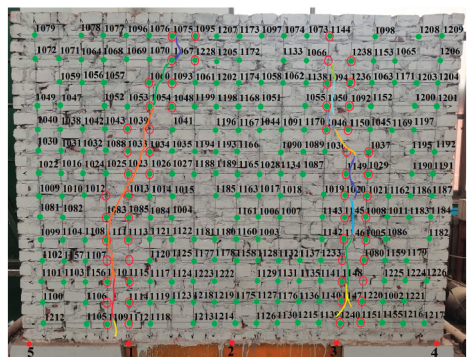
Figure 12: The identification code (ID) of the noncoding point.